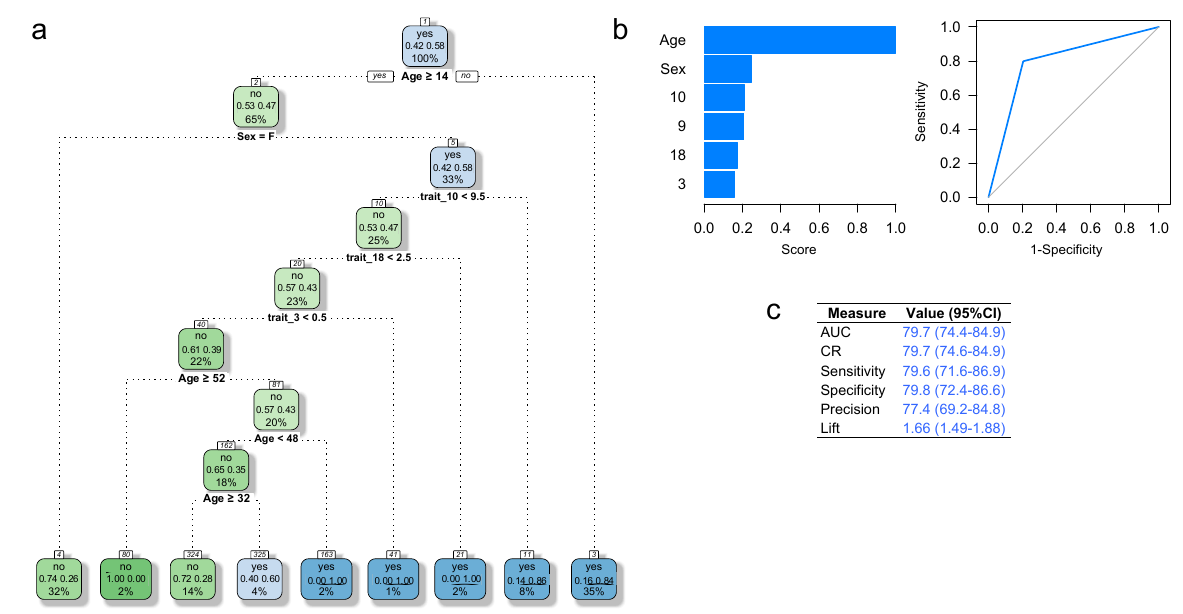
Figure 2. ( a ) Classification tree for predicting ADHD status in individuals from the Colombian Caribbean. Numbers within white squares represent the node number, the first line corresponds to the most frequent class (no: unaffected; yes: ADHD affected), the second line to the probability of each class within the node, and the third line to the percentage of the total sample size ( n = 232) within each node. Nodes where ADHD affected individuals are more likely to be classified are shown in blue . ( b ) Variable importance (left) and ROC curve for the CART strategy. Displayed numbers correspond to task # in Table 2. ( c ) Performance measures for the learning (blue) data set; the grey line represents a naïve classifier. AUC: Area under the curve; CART: Classification and regression tree; CI: confidence interval; CR: Classification rate; ROC: Receiver operating